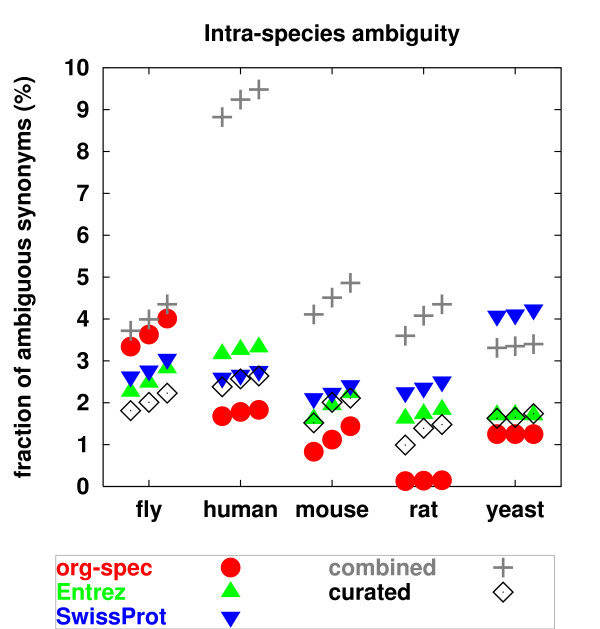
Ambiguity within gene name dictionaries. The ambiguity within gene name dictionaries derived from different data sources and for different organisms varies significantly. Combined dictionaries generally show relatively high ambiguity, curation reduces ambiguity. For notation see Figure 1, for details see section 'Intra-species Ambiguity'.